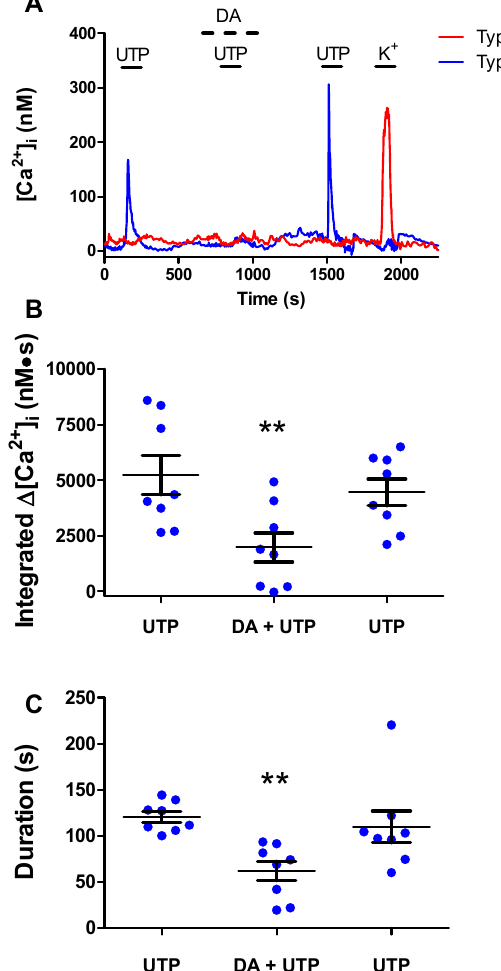
Figure 1. Dopamine attenuates purinergic signaling in type II cells. ( A ) Representative trace